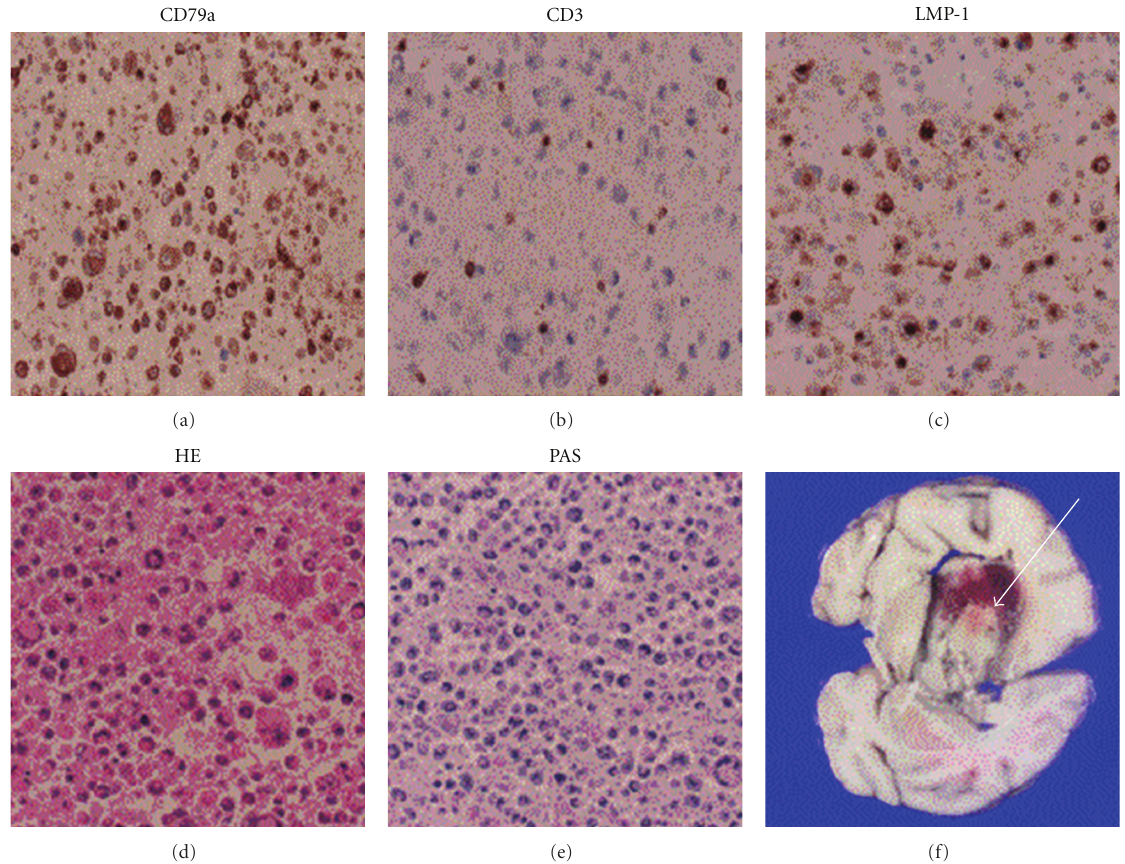
Figure 3: Histology of the brain tumor. Infiltrating cells in the brain tumor were CD79a+, CD3 − , and LMP-1+. Arrow indicates the right paraventricular